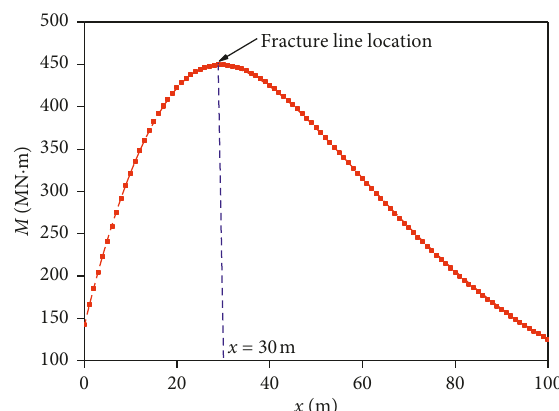
Figure 12: Distribution of bending moment in the cantilever